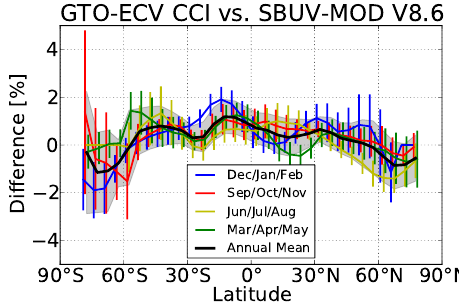
Figure 15. Percentage differences between GTO-ECV CCI and SBUV-MOD 5 ◦ monthly zonal mean ozone columns 1996–2011 as a function of latitude. Black: annual mean difference and its standard deviation (grey shaded area). Blue, red, yellow, and green lines denote the differences for northern hemispheric winter, au- tumn, summer, and spring,